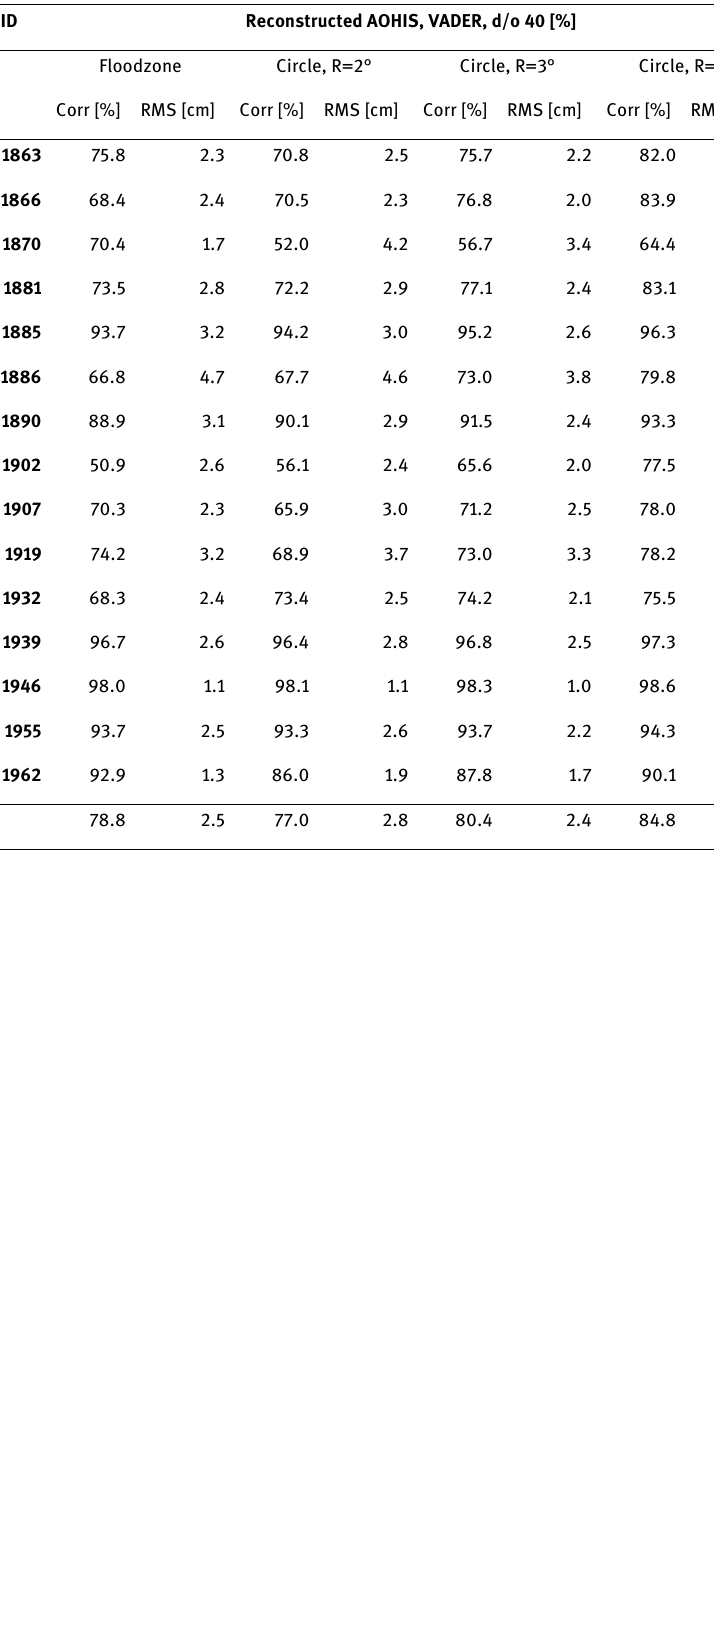
Table 5. Correlation [%] and RMS [cm] of reconstructed and VADER filtered AOHIS signal to the original ESA ESM AOHIS for the 15 selected study cases (d/o